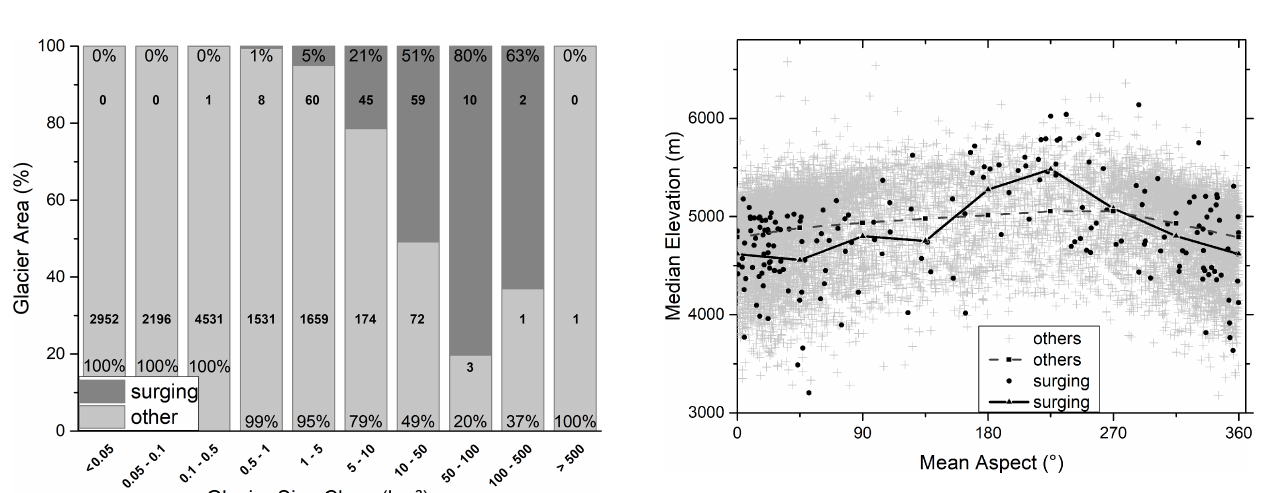
Figure 9. Mean aspect vs. median glacier elevation for surging and other glaciers. The connected lines are averages per aspect